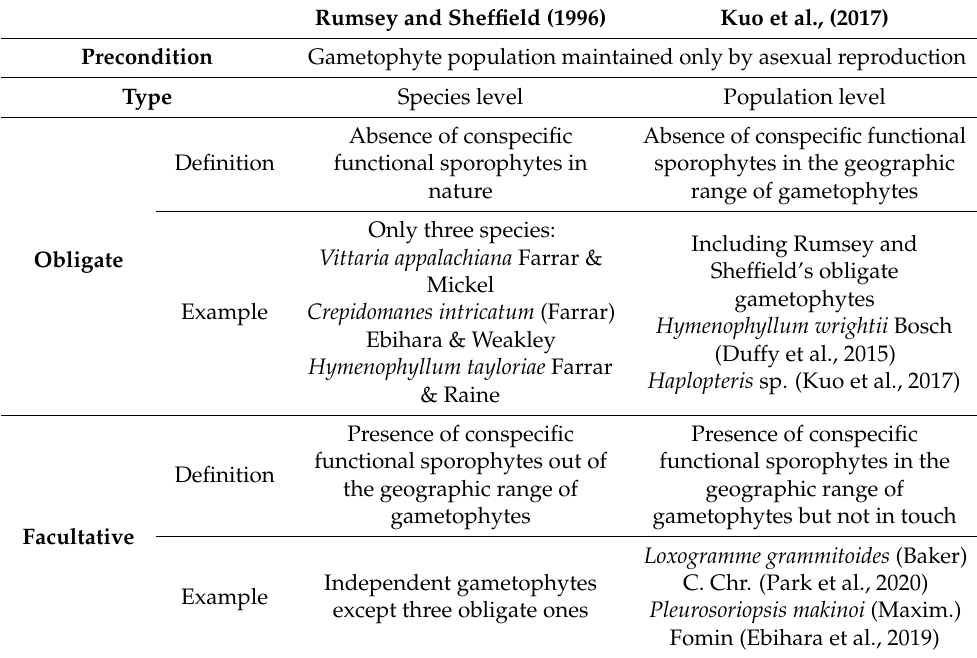
Table 1. Classification of fern gametophyte